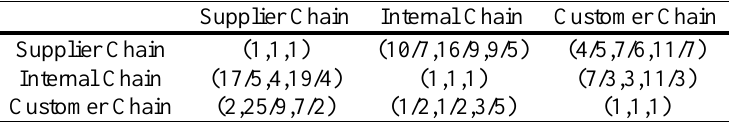
Table 5. Updated pair wise comparison matric of major part.